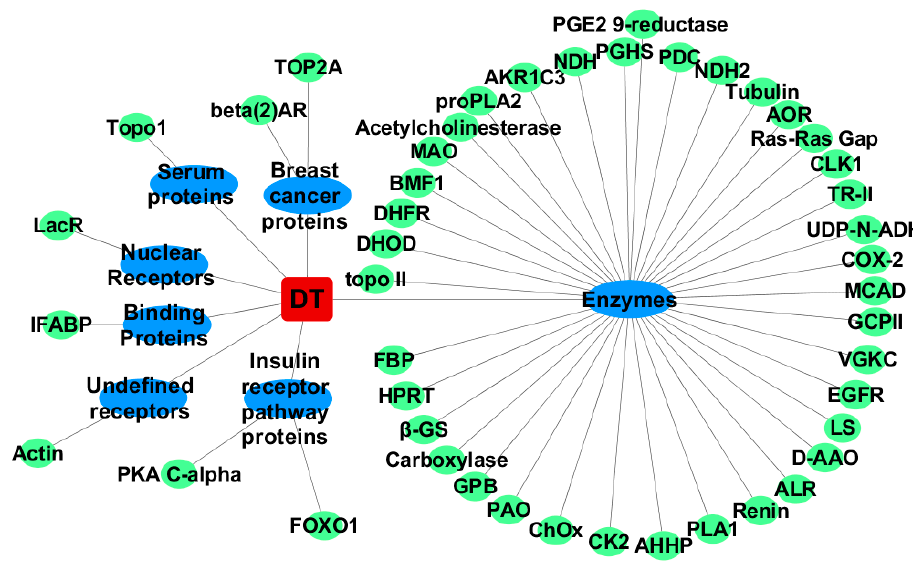
Figure 1. The network of CDT and the screened targets.